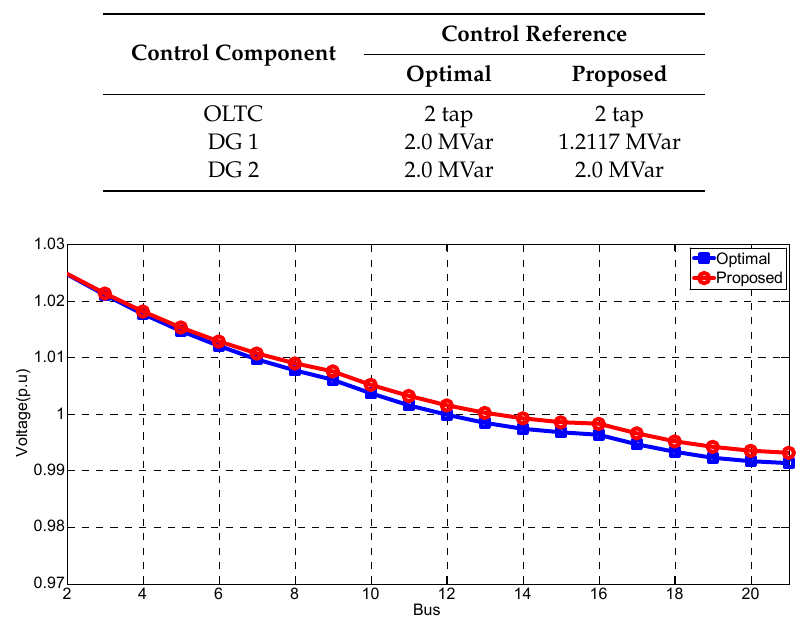
Figure 18. Comparison of results for nominal voltage in case 1.